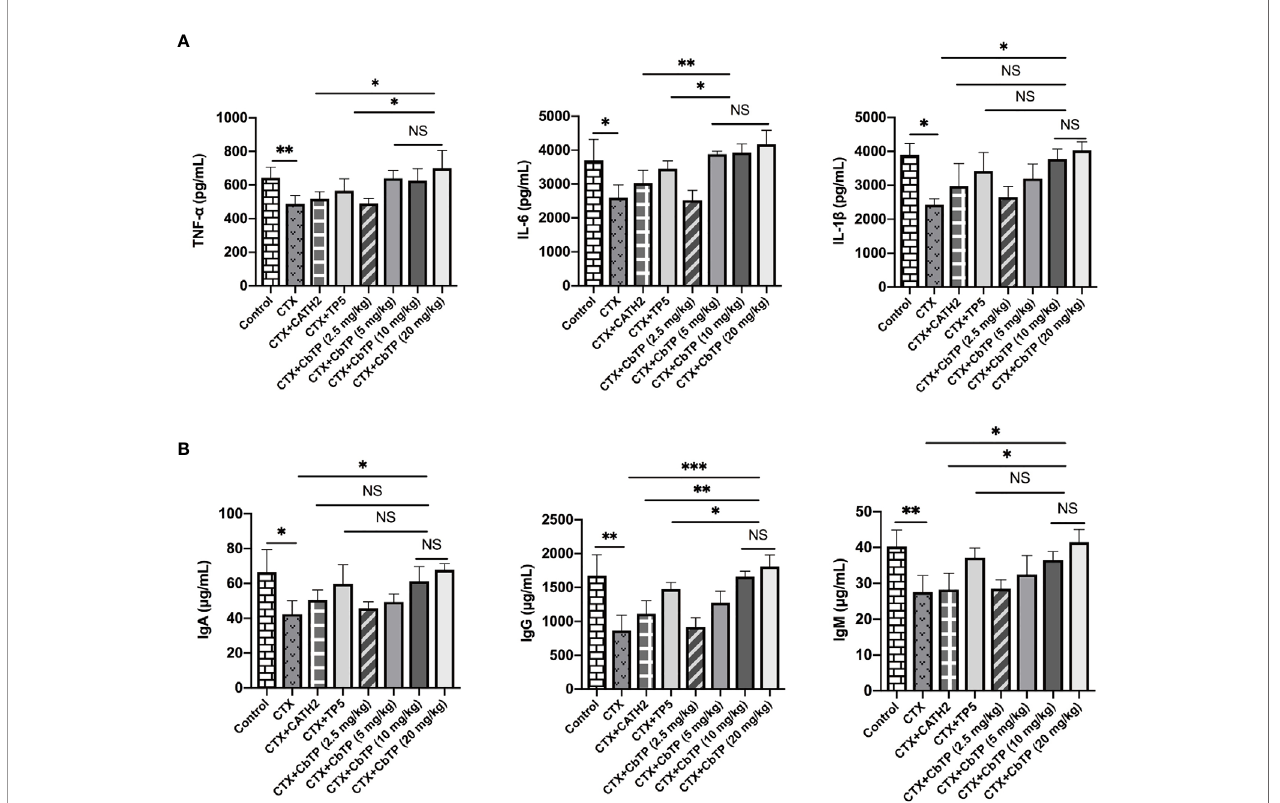
FIGURE 7 | Effects of CbTP on serum cytokines and immunoglobulin levels. (A) Effects of CATH2 (10 mg/kg mouse weight), TP5 (10 mg/kg mouse weight), or CbTP (2.5, 5, 10 or 20 mg/kg mouse weight) on TNF- a , IL-6, and IL-1 b levels in mice immunosuppressed by cyclophosphamide (CTX). ELISA quanti fi cation of TNF- a , IL-6, and IL-1 b levels in the serum of mice from different groups. (B) Effects of CATH2 (10 mg/kg mouse weight), TP5 (10 mg/kg mouse weight), or CbTP (2.5, 5, 10 or 20 mg/kg mouse weight) on IgA, IgG, and IgM levels in mice immunosuppressed by CTX. Levels of IgA, IgG, and IgM in the serum of mice from different groups were determined through ELISA. Statistical comparisons were performed by Student ’ s t test. The data are shown as the mean ± standard deviation (n=12). NS: p > 0.05, *p ≤ 0.05, **p ≤ 0.01, and ***p ≤